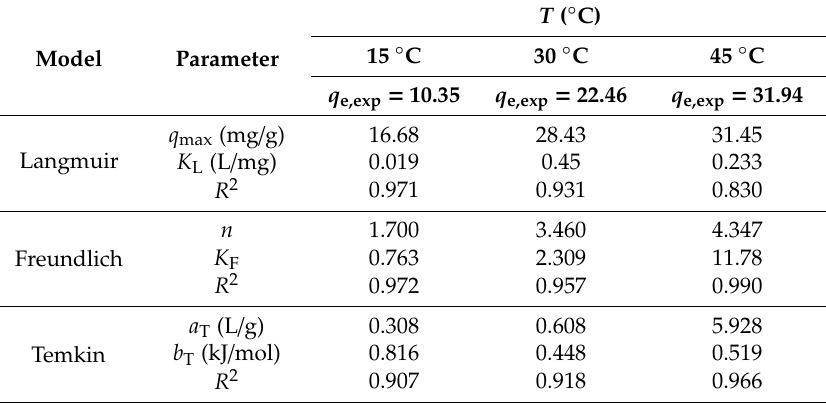
Table 4. Langmuir, Freundlich and Temkin isotherm parameters for Cd(II) adsorption on magnetic graphene oxide.